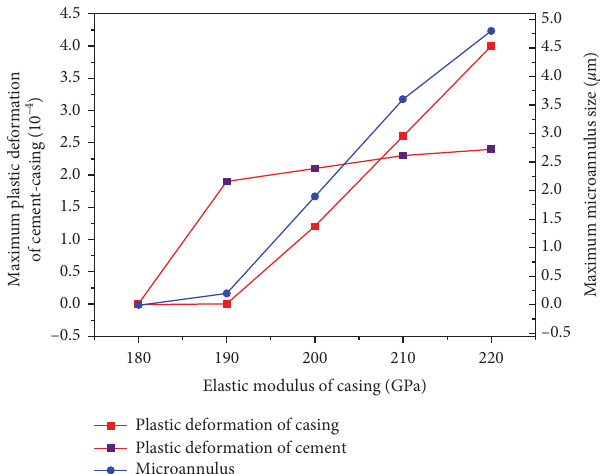
Figure 12: Influence of the elastic modulus of the casing on microannulus